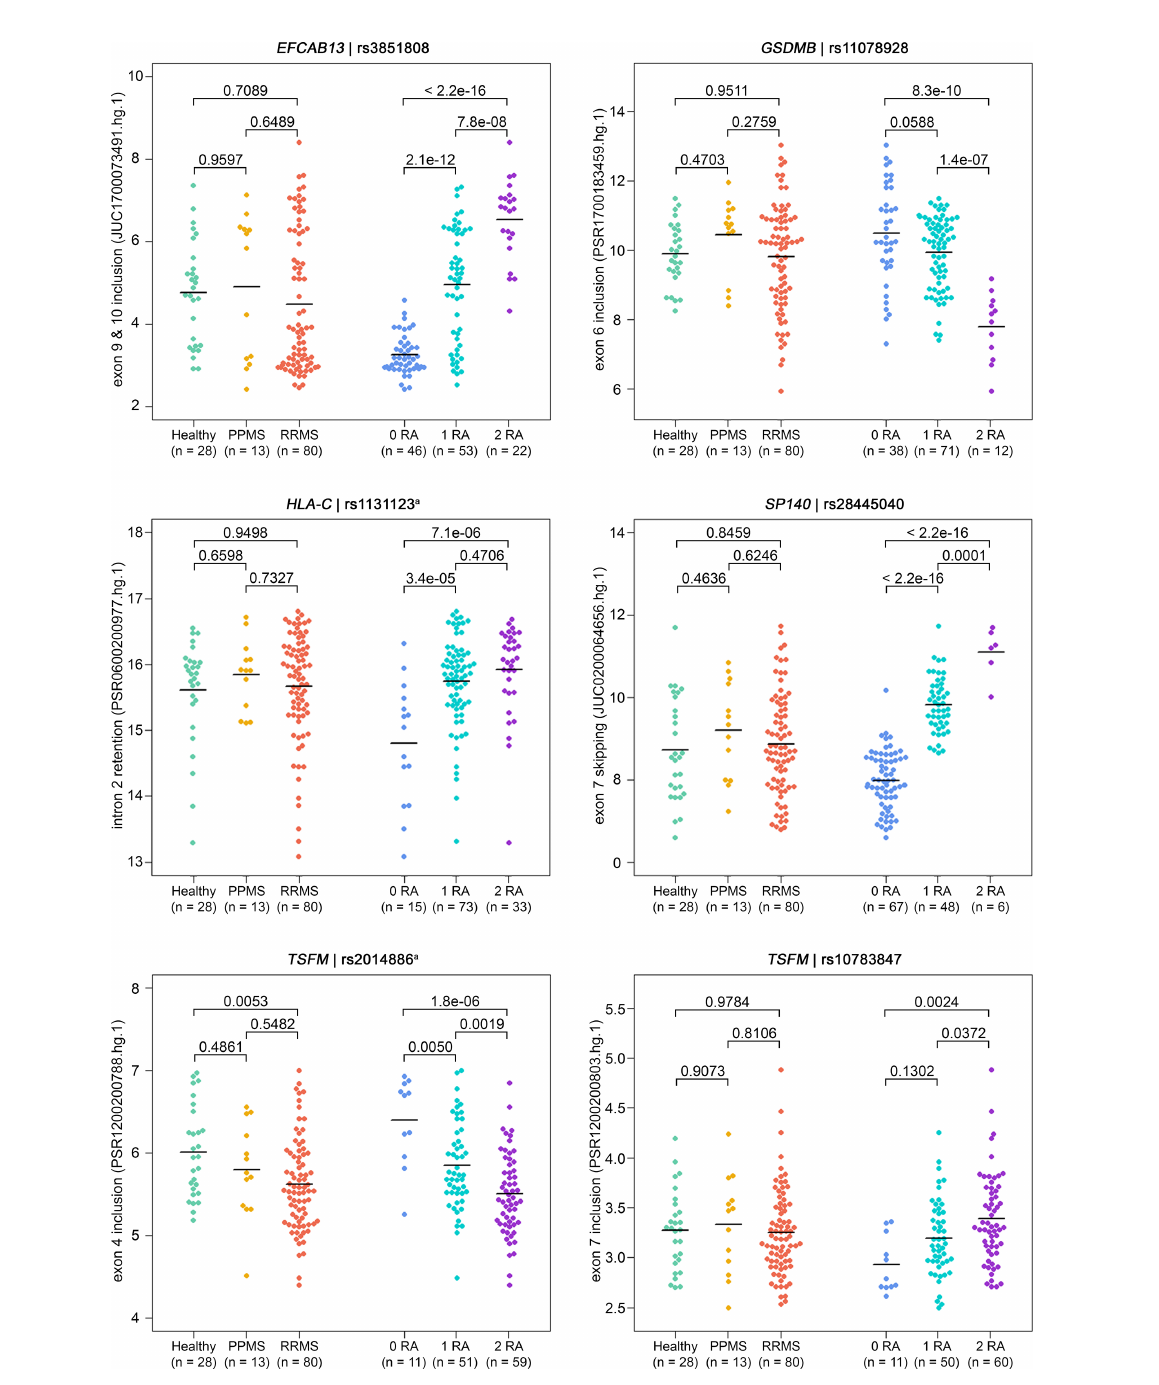
FIGURE 2 Detection of ASEs in transcriptome data from the B cells of MS patients vs . healthy controls and in relation to splice SNP genotypes. For all 121 samples, the expression of individual exons and exon – exon junctions was interrogated using PSR and JUCs, respectively. Signal intensities (in log2 scale) and group means (black lines) are depicted for the ASEs of the six SNP – gene pairs for which we found signi fi cant associations with the genotype (Table 4). Shown are the comparisons of expression levels between the three study groups (on the left) and between the splice SNP genotypes (on the right). P-values from pairwise Tukey post-hoc analyses and the numbers of samples per group are given. The numbering of exons and introns is as speci fi ed in Table 1. a For technical reasons, the designated splice SNP was tagged by a proximal SNP (Supplementary fi le). ASE, alternative splicing event; JUC, junction probe set; MS, multiple sclerosis; PPMS, primary progressive MS; PSR, probe selection region; RA, risk allele; RRMS, relapsing – remitting MS; SNP, single-nucleotide